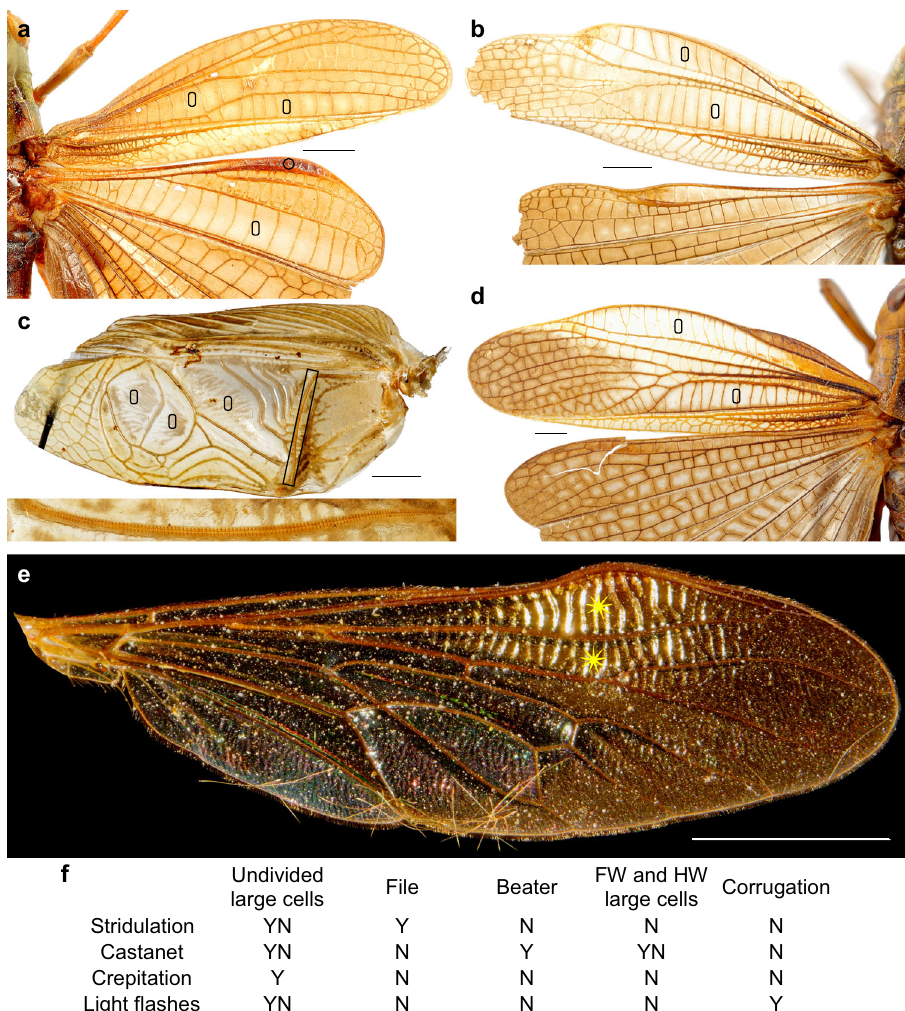
Fig. 2 Structures in extant insects used to communicate. ( a , b , d Acrididae), ( c Gryllidae), ( e Asilidae). a Stenobothrus rubicundulus Kruseman & Jeekel, 1967, with enlarged cells (0) of castanet apparatuses on fore- and hind wings, and beater (°) on hind wing anterior margin. b Stauroderus scalaris (Fischer von Waldheim, 1846) male, enlarged cells (0) of crepitation zones. c Gryllus bimaculatus De Geer, 1773, male, stridulatory apparatus with enlarged cells (0) and fi le (narrow rectangle and detail below). d Arcyptera fusca (Pallas, 1773), enlarged cells (0) of crepitation zones. e Ommatius torulosus (Becker, 1925) male, corrugated re fl ecting zones (*). Scale bars: 2 mm. f Synthesis of the communication modes used in extant insects with their associated structures. Y yes, N no, YN Etymology . The generic name refers to Theia, the Titanide of light in the Greek mythology, while ‘ titan ’ refers to the common suf fi x of the Titanoptera. The gender of the name is masculine. The speci fi c epithet refers to our friend and colleague Pr.